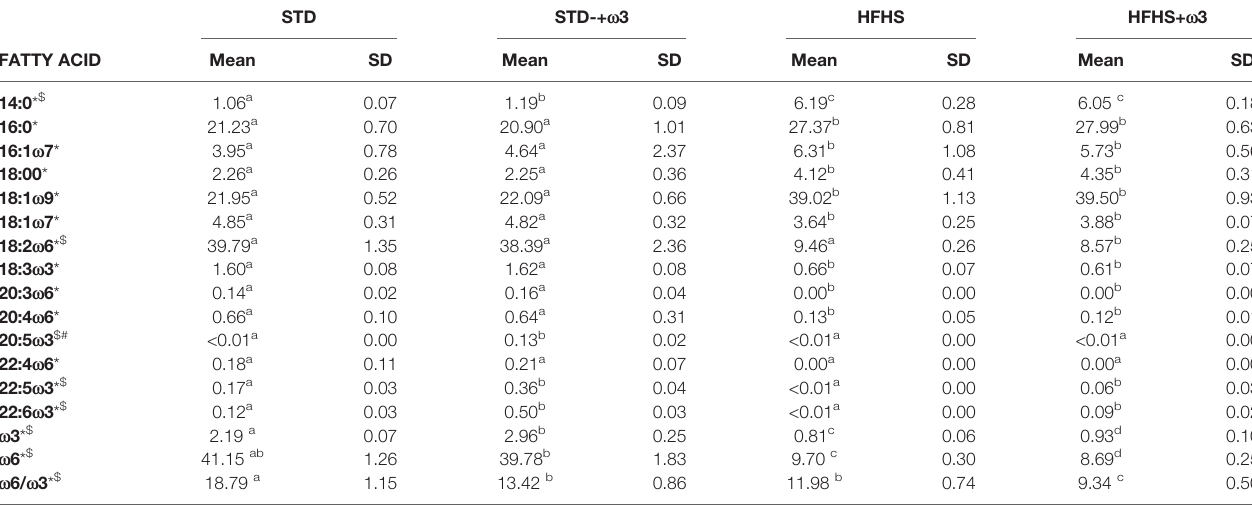
TABLE 2 | Fatty acid composition of the adipose tissue from animals supplemented with STD and HFHS diets divided in controls and w -3 PUFAs supplemented groups. STD STD-+ w 3 HFHS HFHS+ w 3